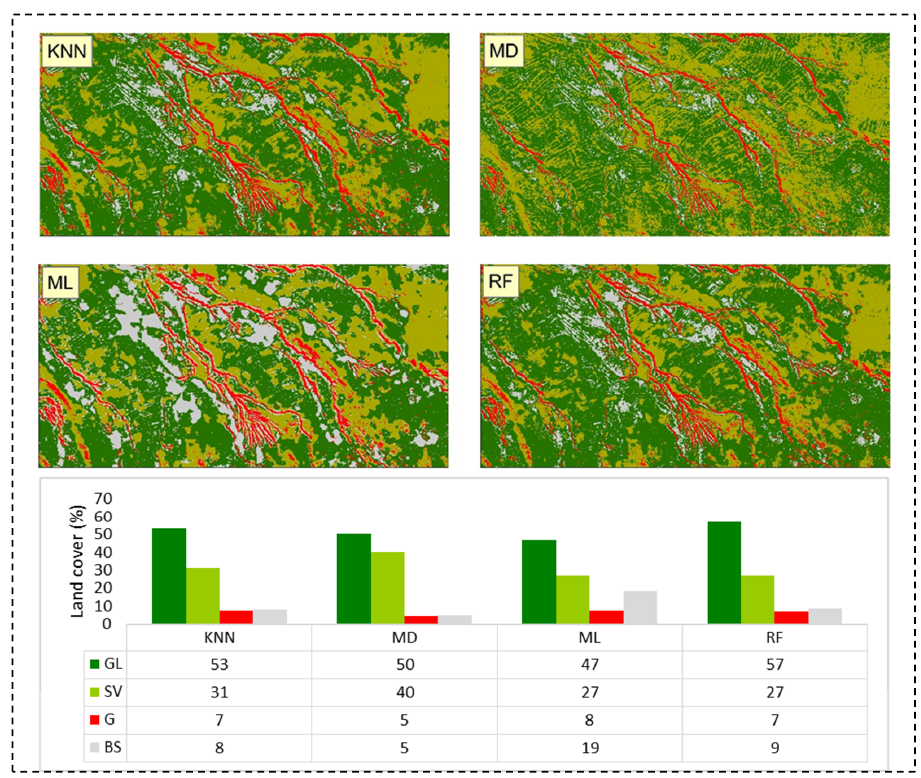
Figure 3. Land cover classification (GL: grassland, SV: stressed vegetation, G: gully, BS: bare soil) based on different algorithms (KNN: k-nearest neighbor, MD: minimum distance, ML: maximum likelihood, RF: random forest).